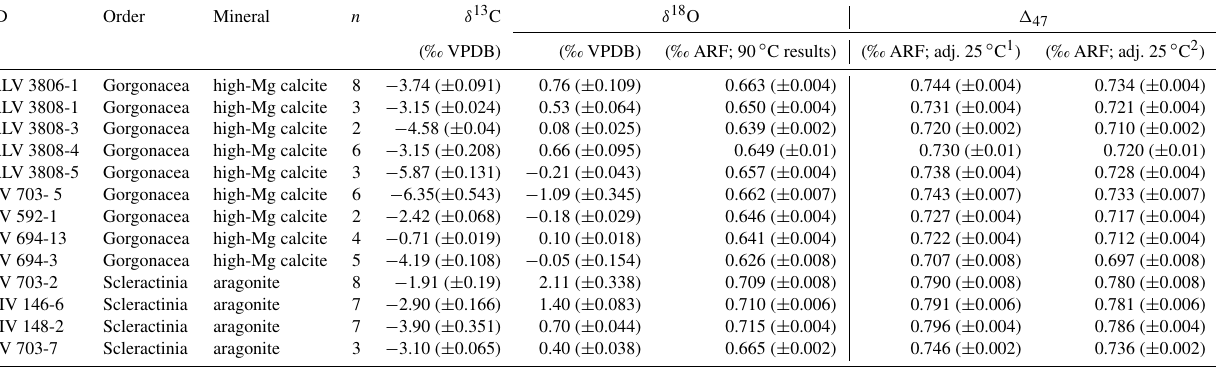
Table 2. Coral specimens analyzed for δ 13 C, δ 18 O, and (cid:49) 47 . (cid:49) 47 is reported relative to the absolute reference frame (ARF). Standard error, 1 σ , is reported with number of replicate measurements ( n ). Individual analyses are reported in Table S1. Values are calculated using a 25 to 90 ◦ C AFF = 0.092 (denoted by 1; Henkes et al., 2013) and AFF = 0.082 (denoted by 2; Defliese et al., 2015, and Passey et al., 2010).